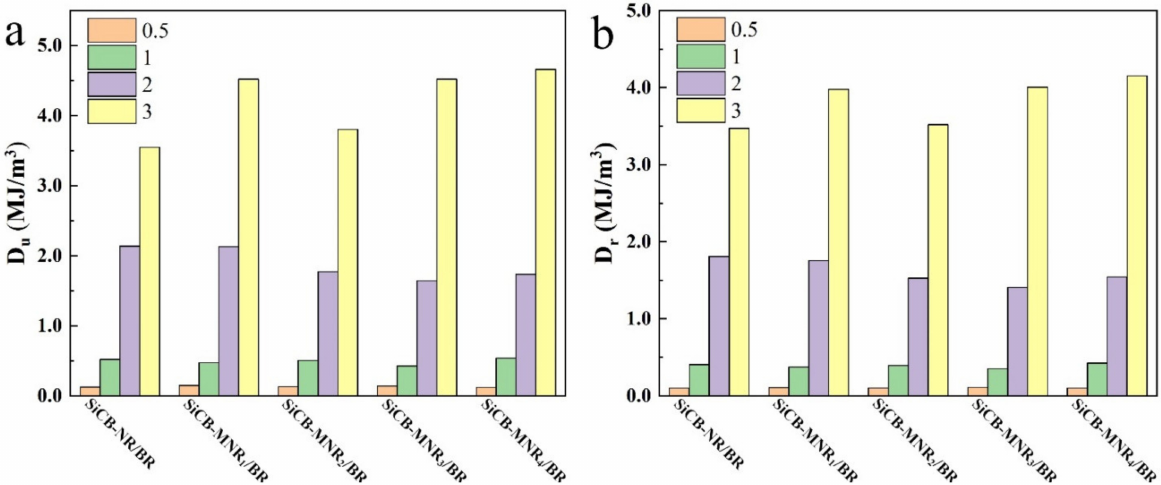
Figure 6. Energy dissipation of SiCB-MNR x /BR composites with different crosslinking densities at different ε during the ( a ) unloading and ( b ) reloading